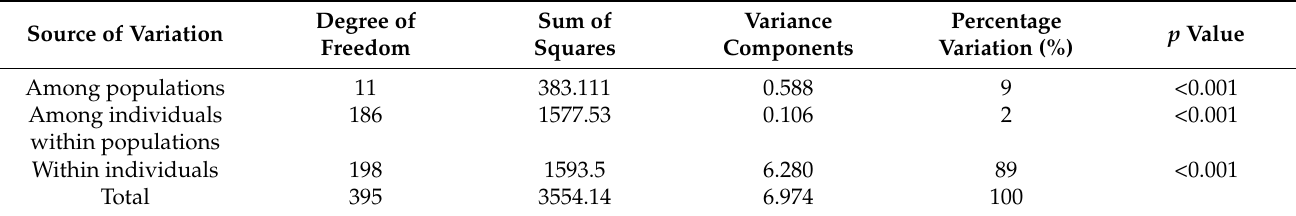
Table 3. Hierarchical AMOVA results among 12 walnut populations generated from 31 SSR loci.